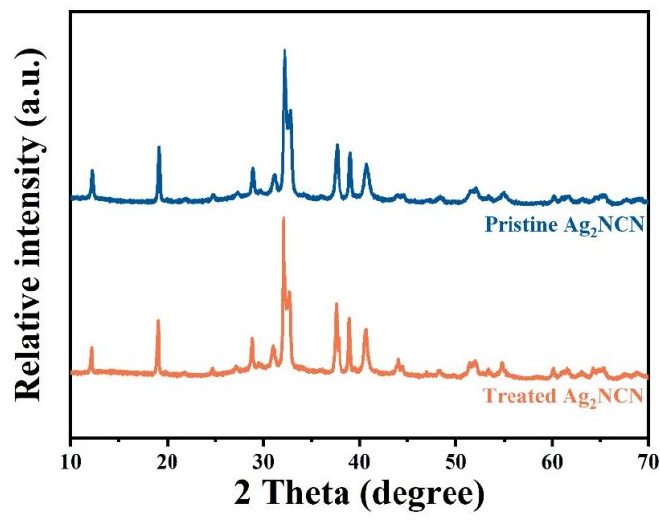
Figure 3. XRD spectra of Ag 2 NCN before and after treatment.